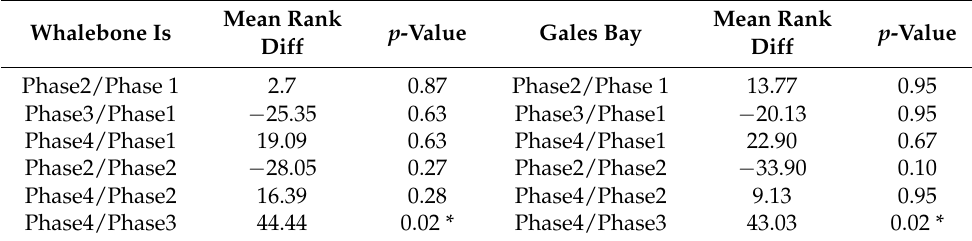
Table 2. Effect of El Niño–Southern Oscillation and Indian Ocean Diploe phase combination on turbidity at two locations in the Exmouth